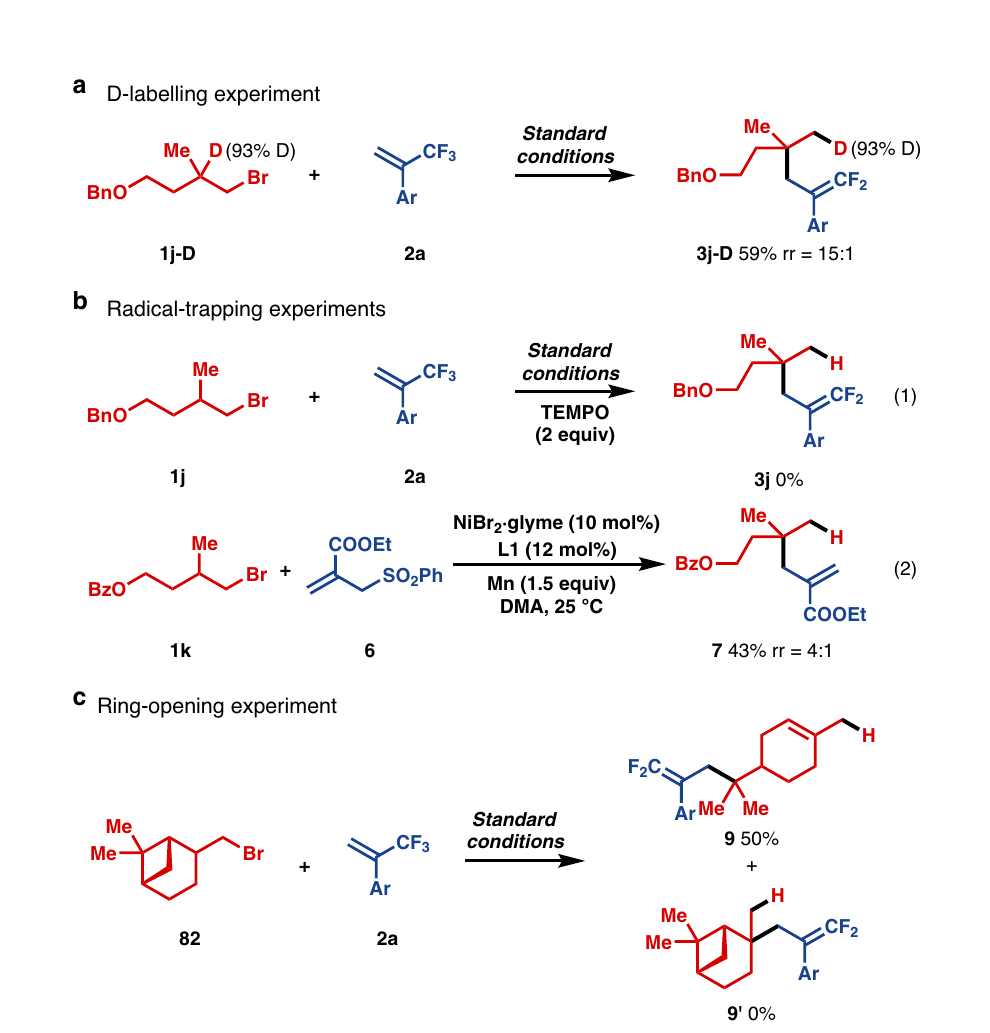
Fig. 2 Control experiments (Ar = 4-MeO 2 C-C 6 H 4 ). a A deuterium-labelling experiment; b radical trapping experiments; c ring-opening experiment.